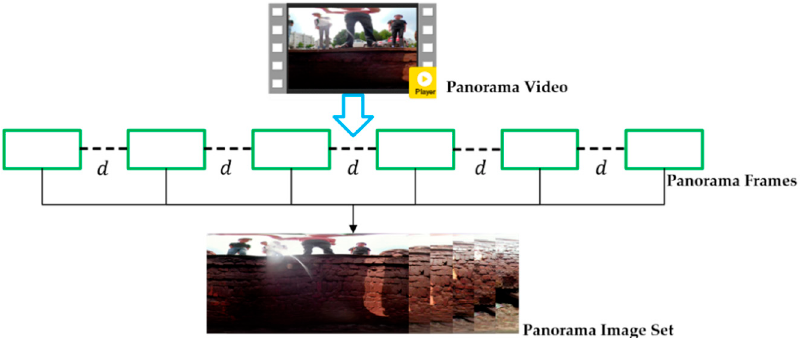
Figure 2. Panoramic frames extraction process; 𝑑 is the interval of